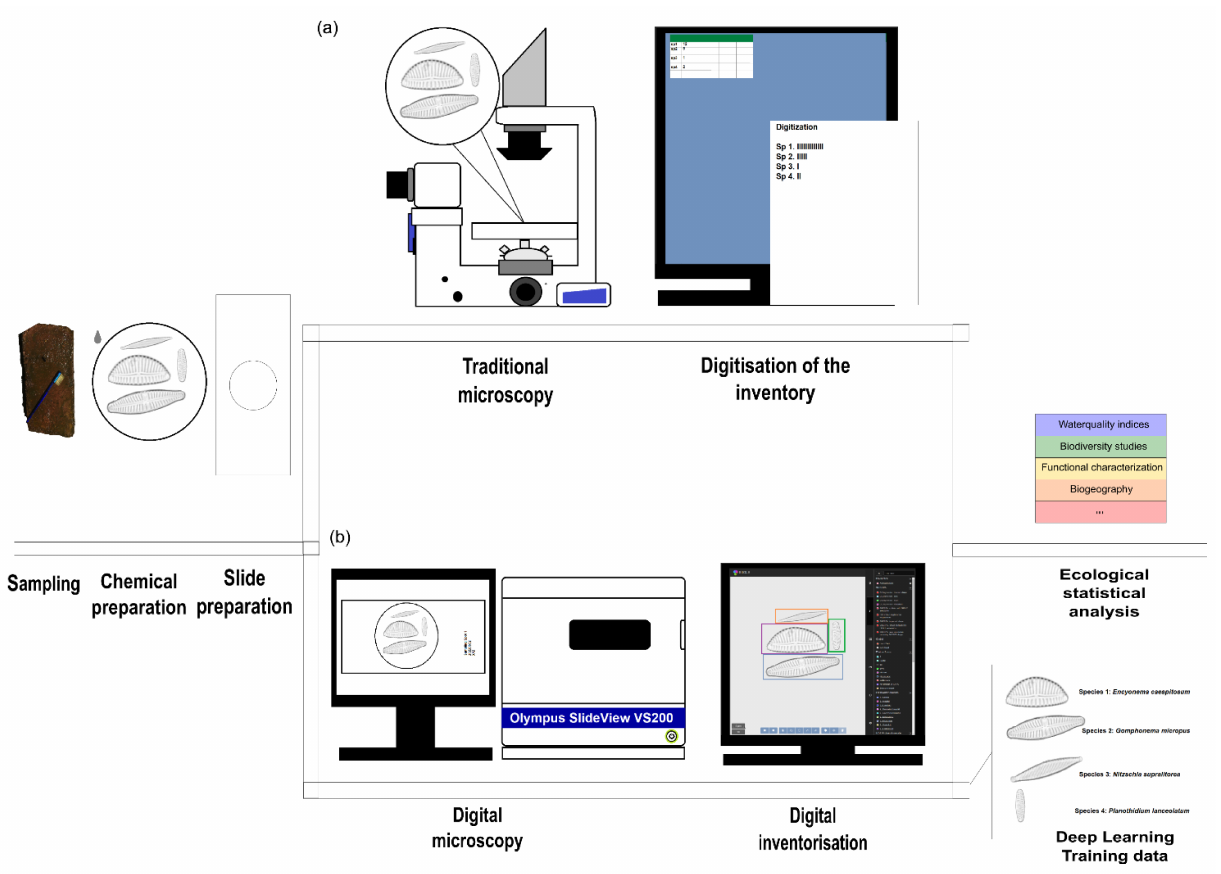
Figure 1. Comparison of the methods used for diatom identification and counting. Note that the identical slides were used for the “traditional” light microscopy path ( a ) as well as for the digital slide scanning methodology ( b ). Samples were collected following UNE EN 13946 (2014), then chemically prepared, dripped onto coverslips and mounted on a slide. ( a ) A square subsection